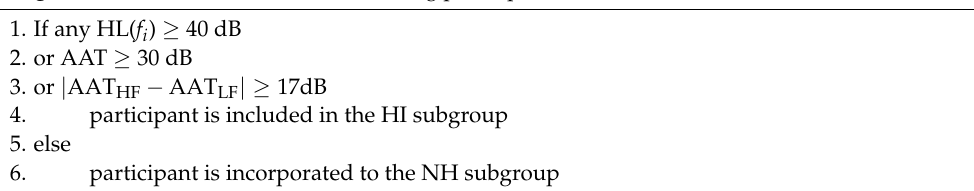
Algorithm 1: Division of different listening